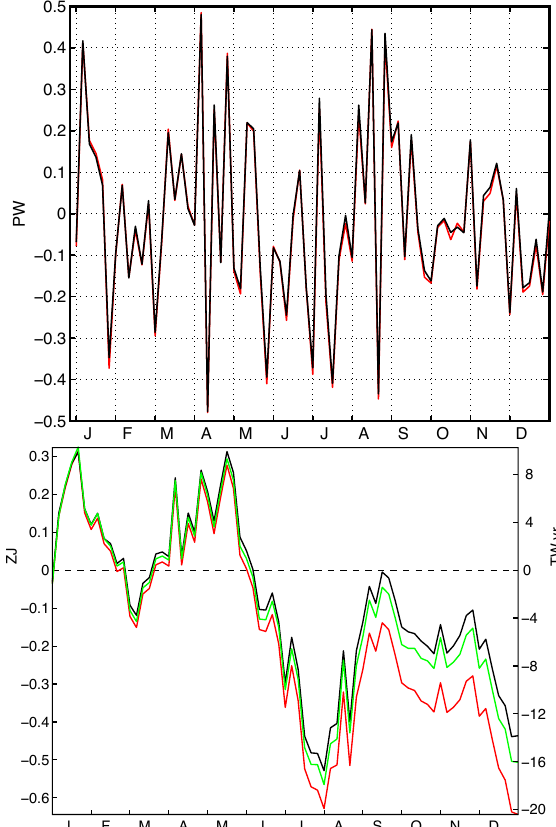
Fig. 7. Results for the equatorial region: (a) rate of change of heat content (black – calculated from the instantaneous datasets) and sum of the advection and diffusion terms (red – calculated from the 5-day mean datasets). Heat flux in PW. (b) Total heat content (black – from instantaneous datasets) plus cumulative integrals of heat fluxes calculated using mean datasets (red) and instantaneous datasets (green). Heat content in ZJ (10 21 J), also shown as TW years.